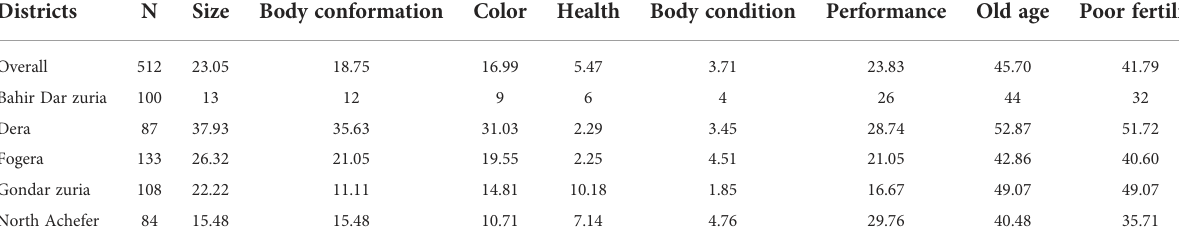
TABLE 6 Weighted proportion (in percent) for the culling criteria of female animals. Districts